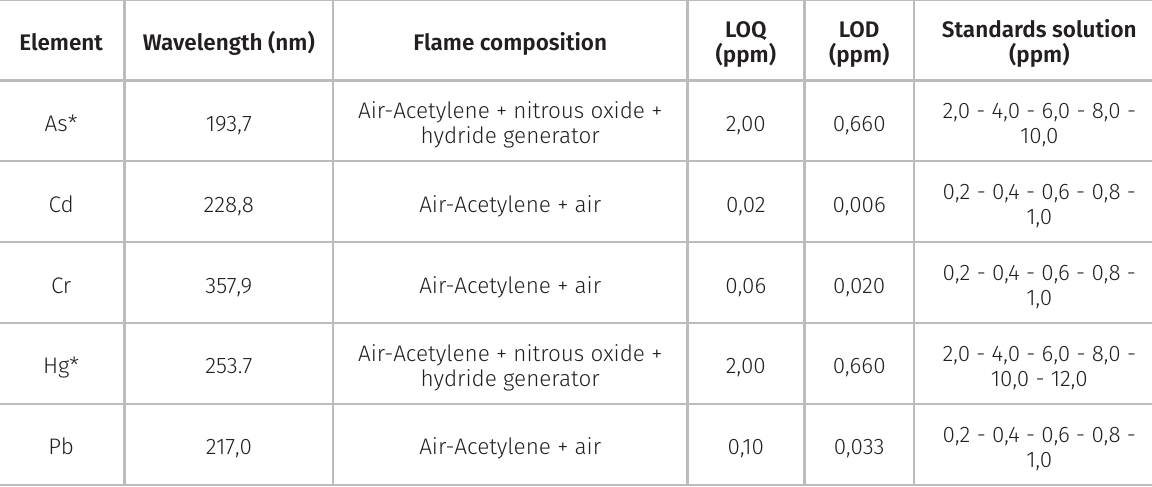
Table II. Individual conditions of the metals for reading under FAAS.